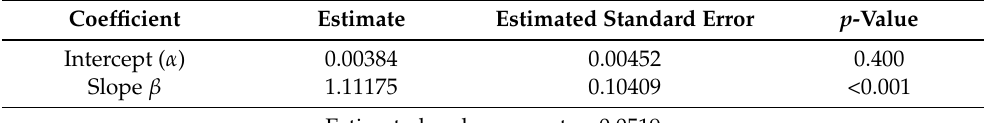
Table 4. Linear regression for the CAPM under normality with data of CMPC monthly returns. Coefficient Estimate Estimated Standard Error p -Value Intercept ( α ) 0.00384 0.00452 0.400 Slope β 1.11175 0.10409 <0.001 Estimated scale parameter: